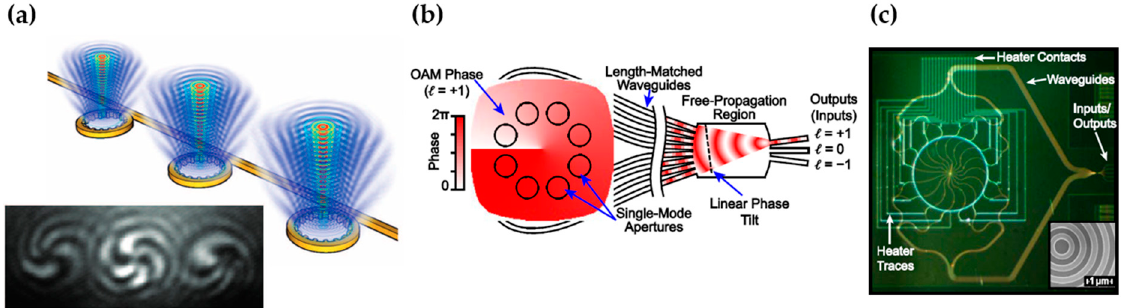
Figure 12. ( a ) Schematic of three OAM beam generators based on mirroring resonators with angular gratings (top). The bottom figure shows the interference pattern between three OAM beams ( l = − 3) and a co-propagating right-handed circularly-polarized beam. From [84]. Reprinted with permission from AAAS. ( b , c ) Schematic and optical images of an OAM beam encoder/decoder based on a silicon photonic integrated circuit. Reprinted with permission from [10] © The Optical Society.